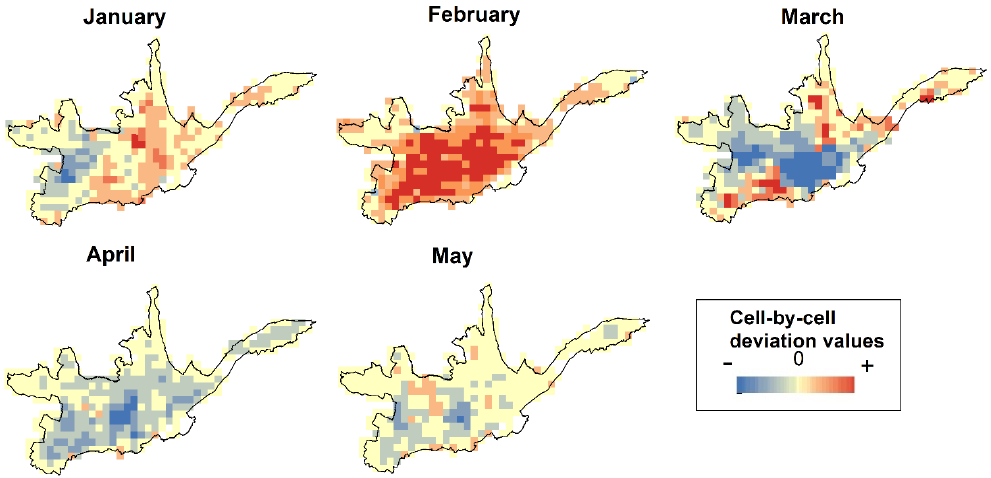
Figure 10. Cell-by-cell deviations to the selected June grid.